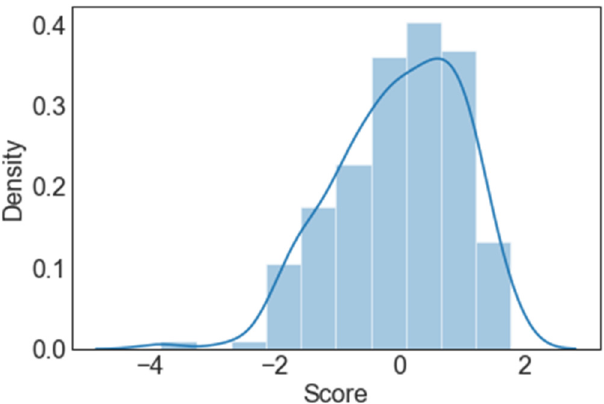
Figure 6. E-commerce awareness and loyalty score distributions.